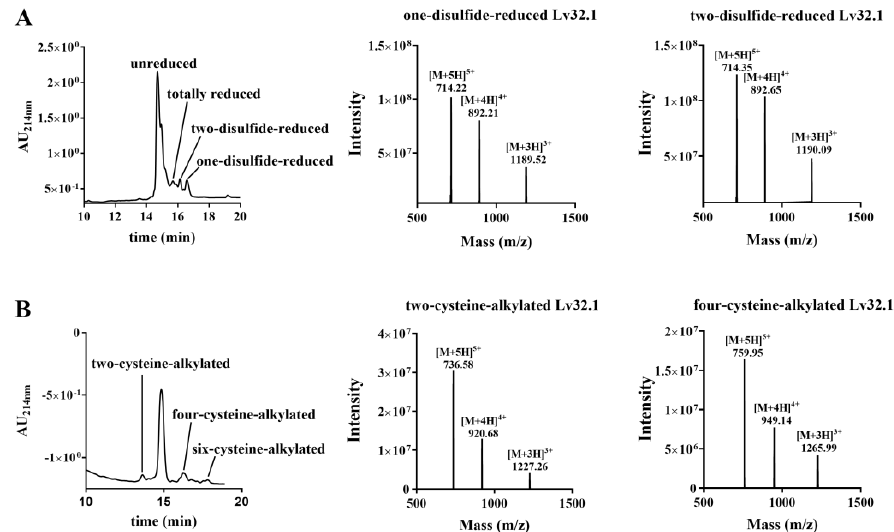
Figure 6. HPLC and LC-MS spectra of stepwise reduction by TCEP and follow-up alkylation by IAM. ( A ) HPLC and LC-MS spectra of stepwise reduction products of Lv32.1. ( B ) HPLC and LC-MS spectra of alkylated products of stepwise-reduced Lv32.1.